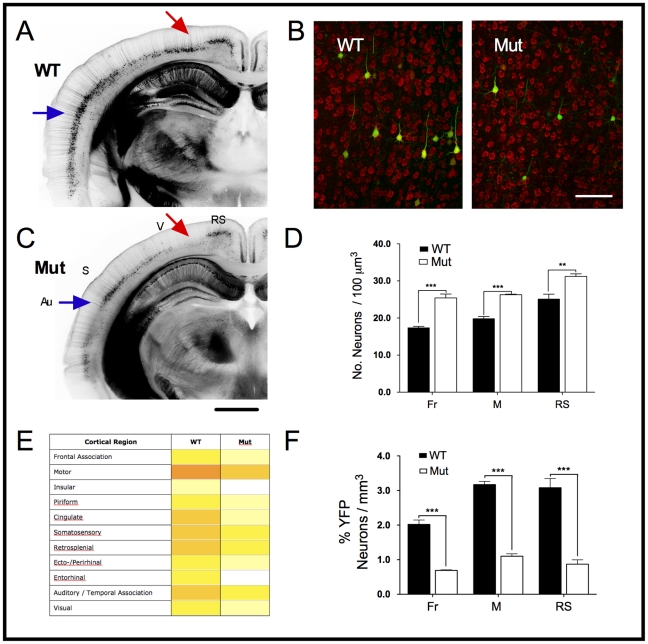
MeCP2J mutant mice have reduced numbers of YFP-expressing cortical neurons.A, C) Fewer YFP+ cells are observed across the entire cortex in mutant males (200 µm coronal sections, ∼ Bregma −2.2 mm in WT). Some cortical regions are more dramatically affected than others, such as visual cortex (red arrow) and auditory cortex (blue arrow). Sharp boundaries correspond to functional regions (Au, auditory; S, somatosensory; V, visual; RS, retrosplenial). Scale bar = 0.5 mm. Overall cortical YFP expression patterns are shown as a qualitative heat map in E), where white indicates few to no neurons and dark orange indicates the most dense cortical labeling. The number of YFP+ cells is generally higher in rostral and medial region in both genotypes. B) Fluorescent Nissl staining (red) of L5 motor cortex. A limited subset of pyramidal neurons express YFP. Scale bar = 100 µm. D) Neuronal density is increased in frontal (Fr), motor (M) and retrosplenial (RS) cortex in mutant mice. F) The percentage of YFP+ pyramidal neurons is reduced in three cortical regions (F, frontal; M, motor; RS, retrosplenial).